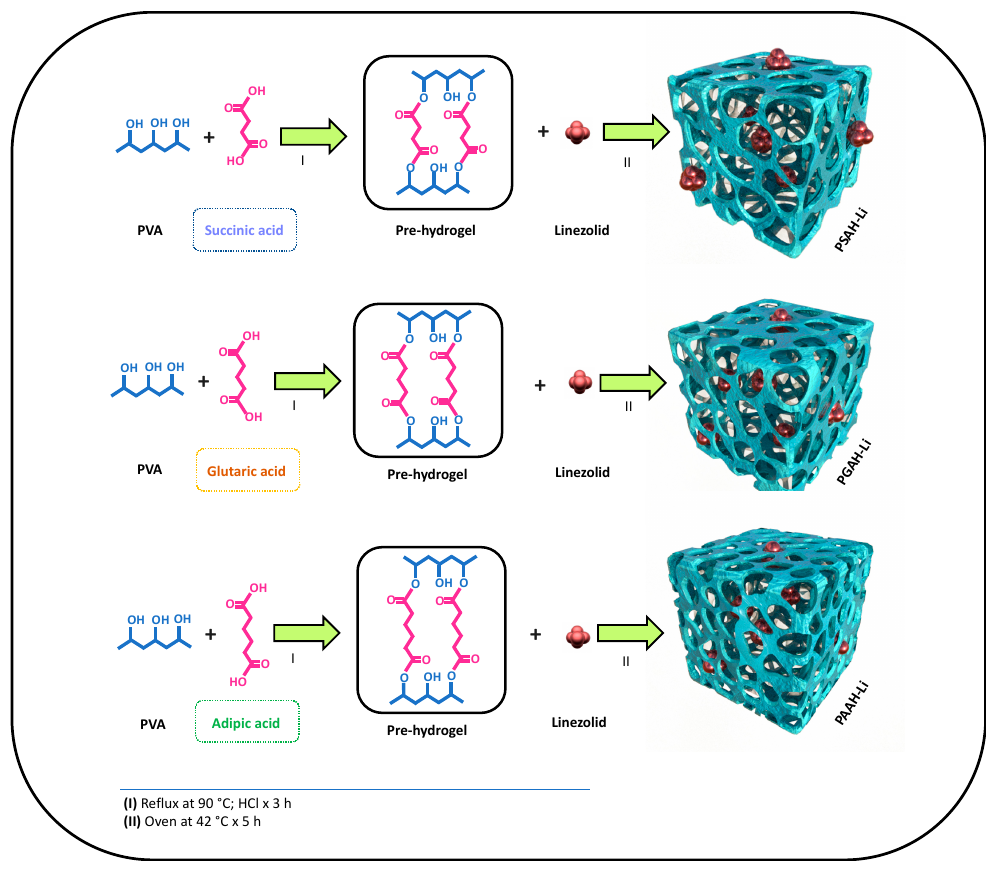
Figure 1. Synthesis and proposed structures of the linezolid-loaded hydrogels.